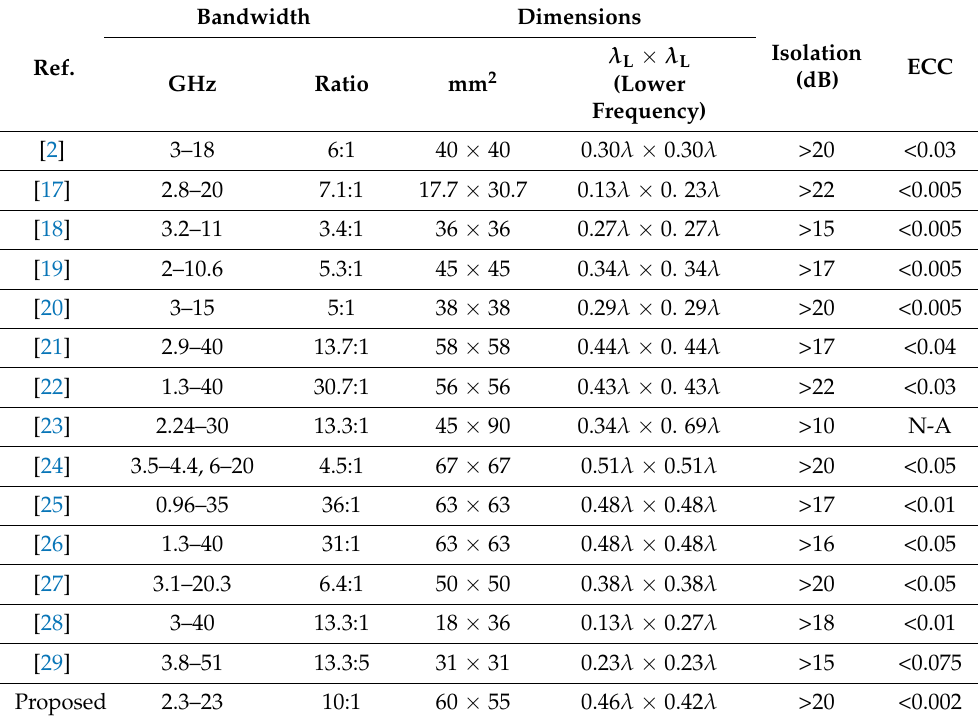
Figure 12. Measured realized gain and efficiency of the MIMO antenna port 1. Table 2. Comparison of the proposed MIMO antenna with other reported antennas.